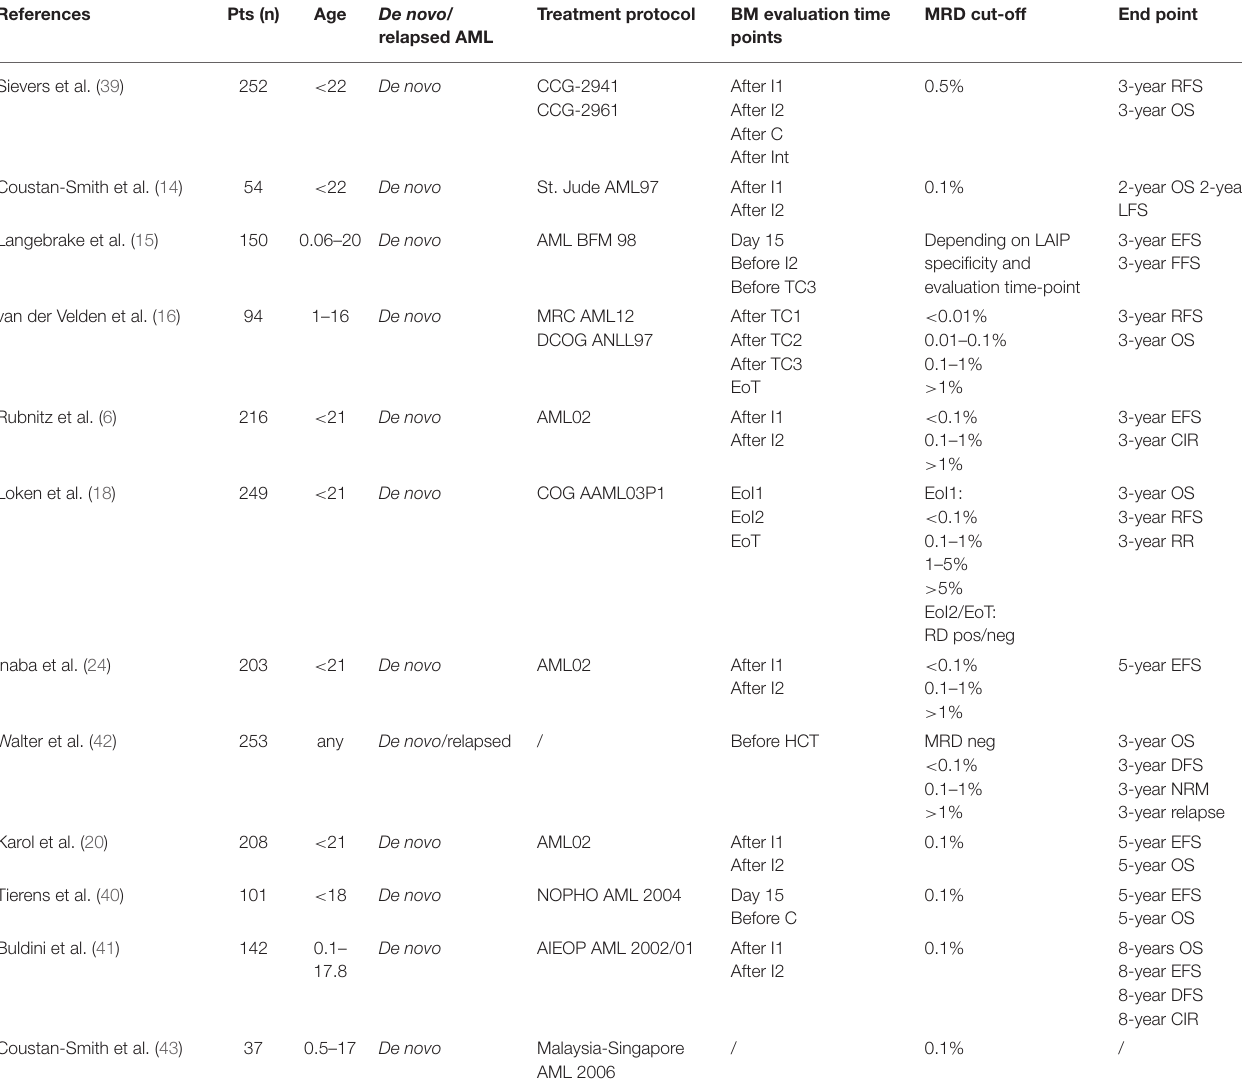
TABLE 1 | Principal studies on the role of MFC-MRD in childhood